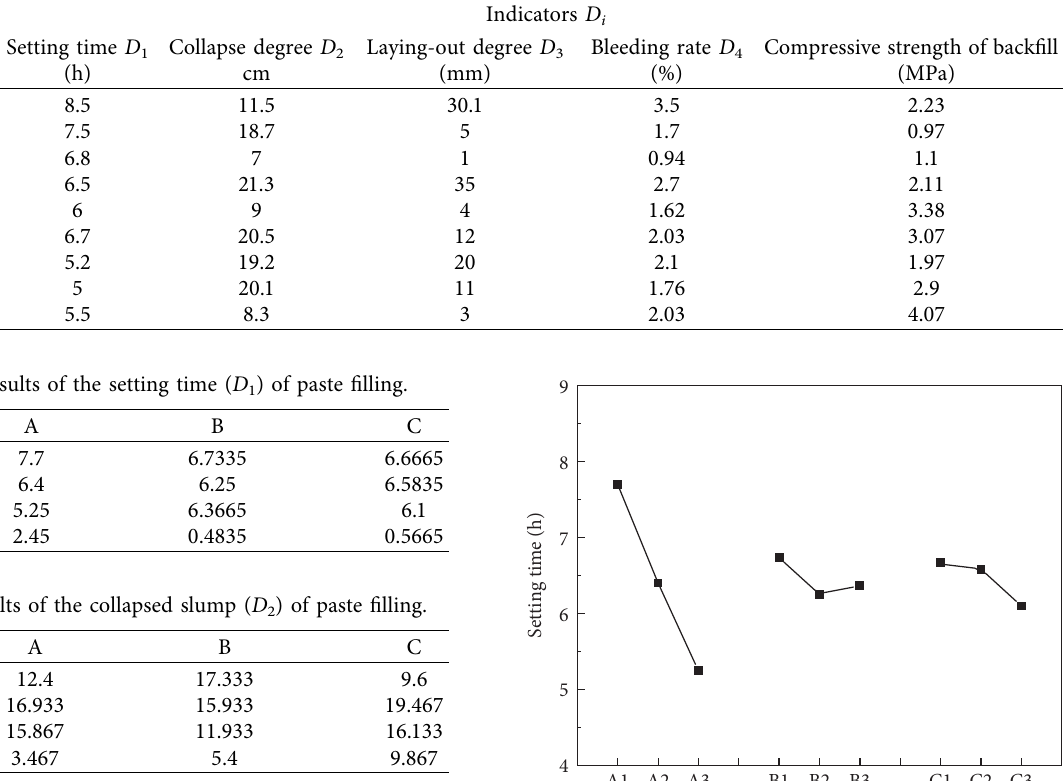
Table 3: Results of the L